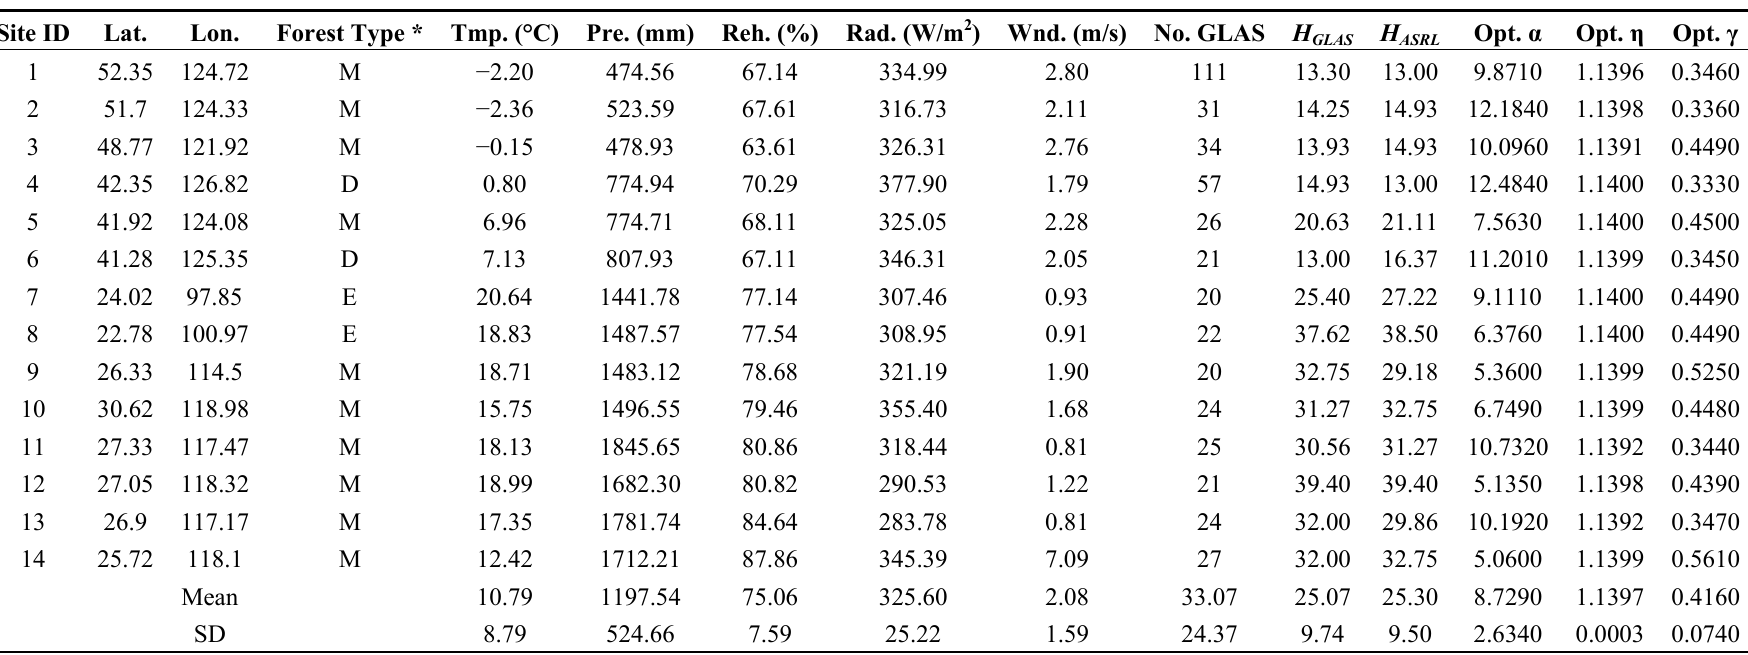
Table 2. 14 selected study sites where ≥ 20 valid GLAS shots were geo-registered within a 10 km radius. The site information includes geo-location (latitude (Lat.) and longitude (Lon.)), forest types, and climatic variables (temperature (Tmp.), precipitation (Pre.), incoming solar radiation (Rad.), wind speed (Wnd.) and relative humidity (Reh.)). The optimized parameter sets (area of single leaf (Opt. α), exponent for canopy radius (Opt. η), and root absorption efficiency (Opt. γ)) were also